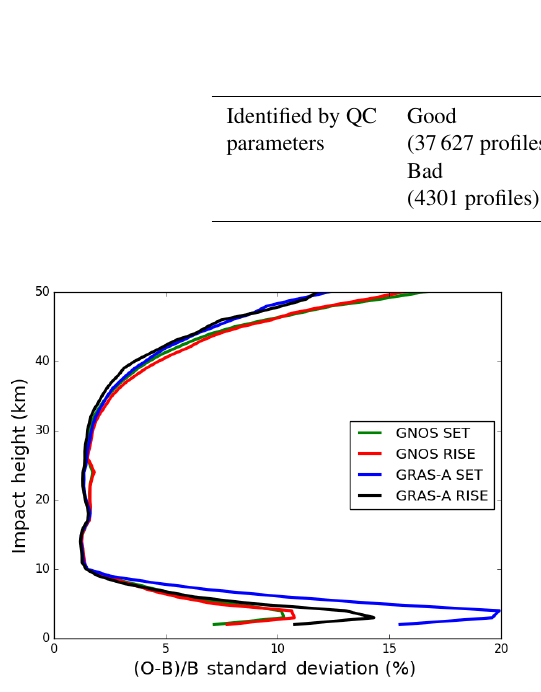
Figure 16. Global bending angle departure results, as a function of impact height, for the standard deviation. The green, red, blue and black lines are representative of setting occultation for GNOS, ris- ing occultation for GNOS, setting occultation for GRAS-A and ris- ing occultation for GRAS-A. O is observation and B is